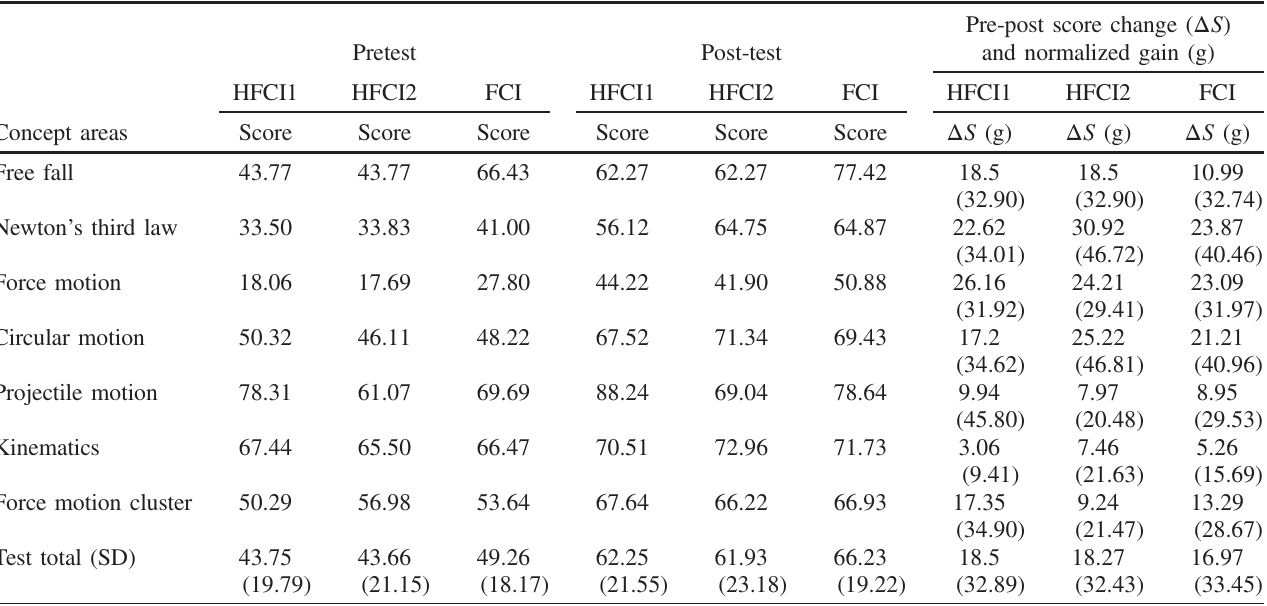
TABLE II. Basic descriptive statistical comparisons of the two half-length tests and the original FCI test. All scores and standard deviations are in the scale of a 100-point score. The score changes ( Δ S ) are calculated based on the average scores of the pre- and